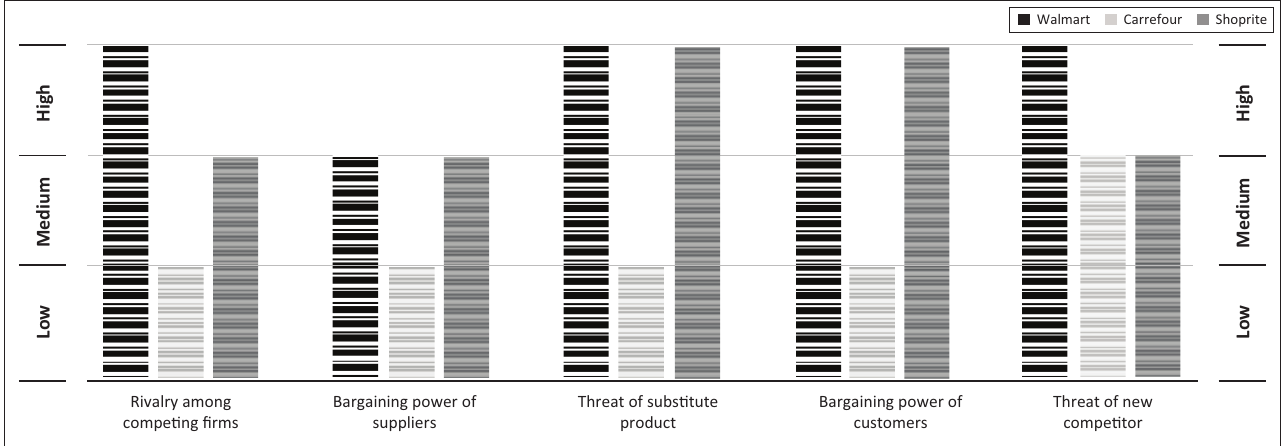
FIGURE 5: Porter’s five forces model